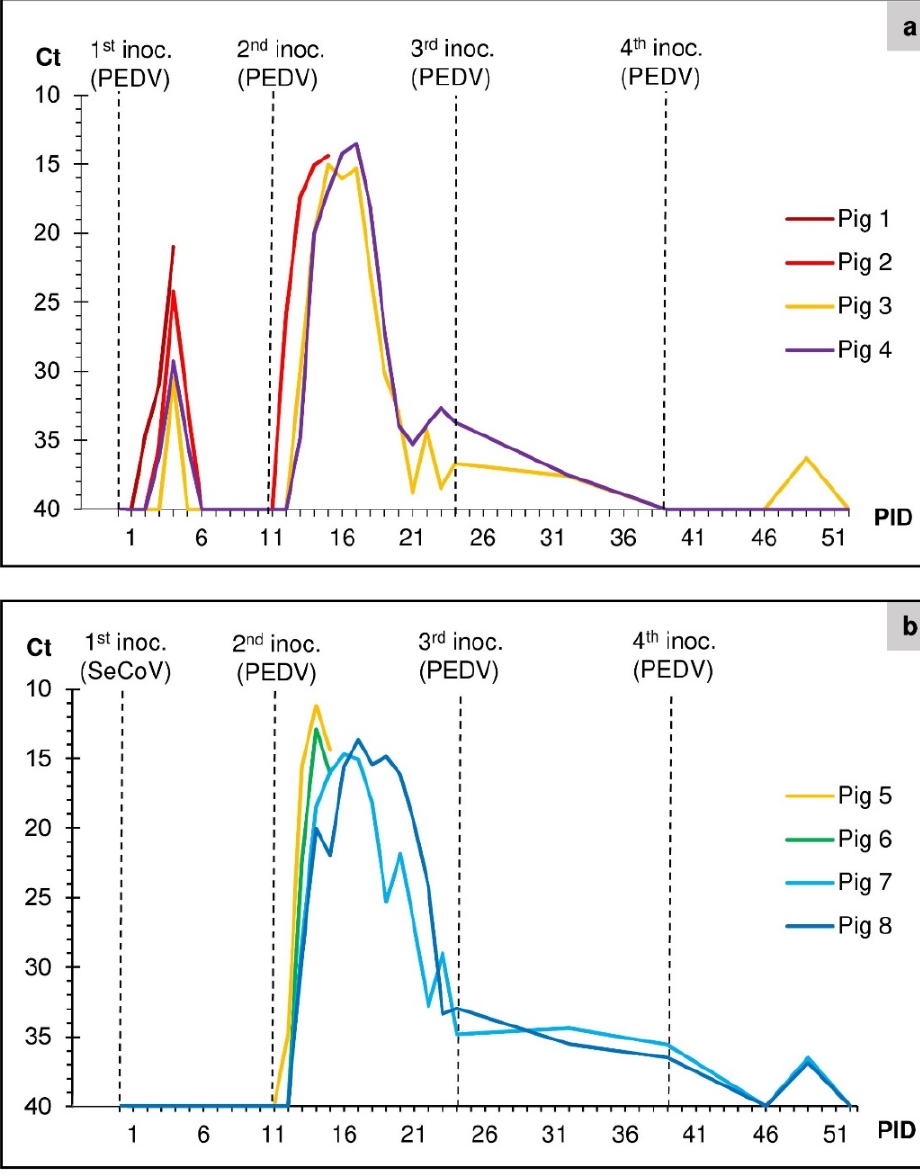
Figure 1. Excretion of PEDV in fecal samples as determined by detecting PEDV RNA using RT-qPCR. Tested samples were given the value of 40 if the cycle threshold (Ct) was not reached after 40 cycles. Panel ( a ) shows the results from pigs in group 1 inoculated with PEDV material from Germany with the 1st–4th inoculations (inoc.) on PID 0, 11, 24, and 39. Pig 1 was euthanized on PID 4, and pig 2 on PID 15. Panel ( b ) shows the results from pigs in group 2 initially inoculated with SeCoV on PID 0 and subsequently with PEDV from Italy on PID 11, 24, and 39. Pigs 5 and 6 were euthanized on PID 15.